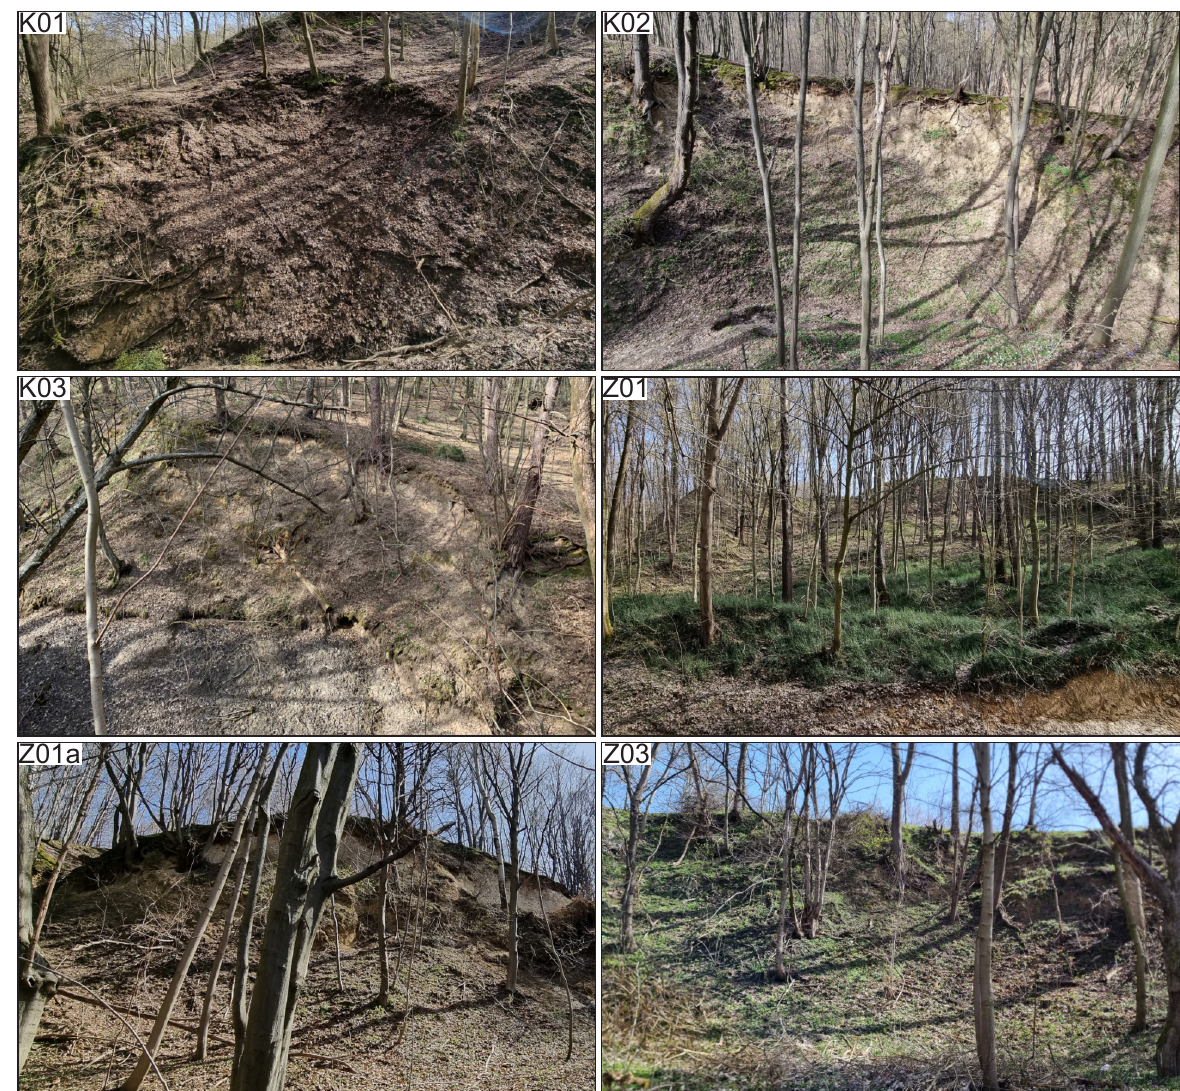
fig. 7. Photos of the slopes covered by the